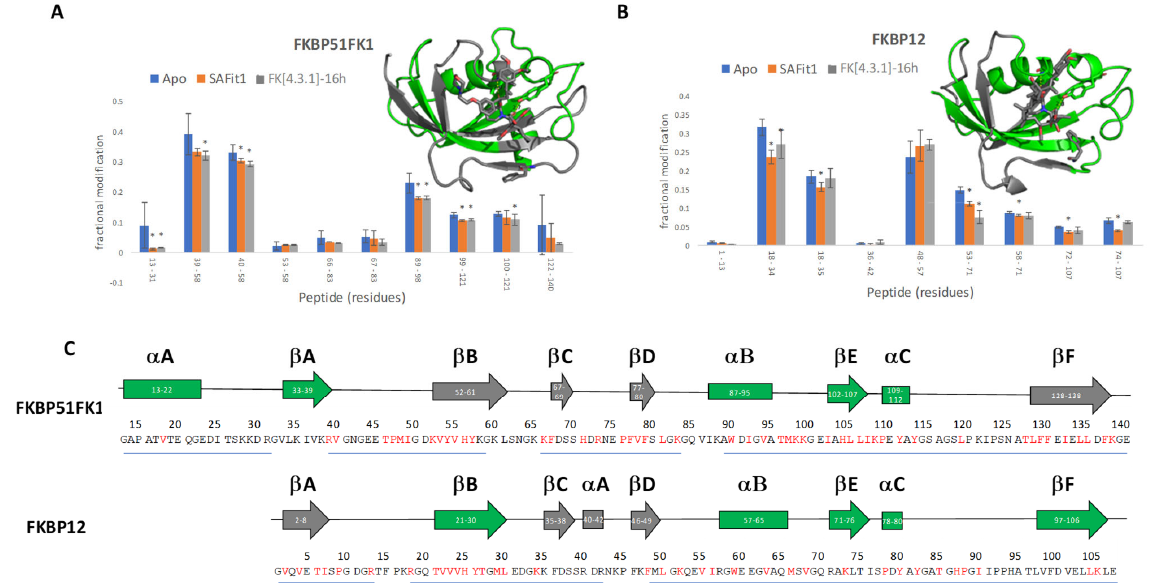
Figure 8. Results of the peptide-level analysis of the FK506-binding proteins: ( A ) fractional oxidative modification of the peptides of FKBP51FK1 for the apo protein as well as SAFit1- and FK[4.3.1]-16h-bound protein, in which statistically significant ( p < 0.05) differences between ligand-bound and -free states are indicated with an asterisk (*). Insets show crystal structures with regions that show reduced oxidation after binding of either ligand in green. ( B ) Fractional modification of the peptides of FKBP12 for the apo protein, as well as ligand-bound states. ( C ) Sequence overview for FKBP51FK1 and FKBP12, with sequence regions covered by the observed peptides underlined. Secondary structure elements are labelled as in Figure 6. Elements that show reduced oxidation after ligand binding are coloured green in Panel ( C ), and unaffected elements are in grey (same colour code as the insets in Panel ( A ); no regions were observed where ligand binding led to increased oxidative labelling). Detected oxidative labelling sites are coloured red in the sequence.